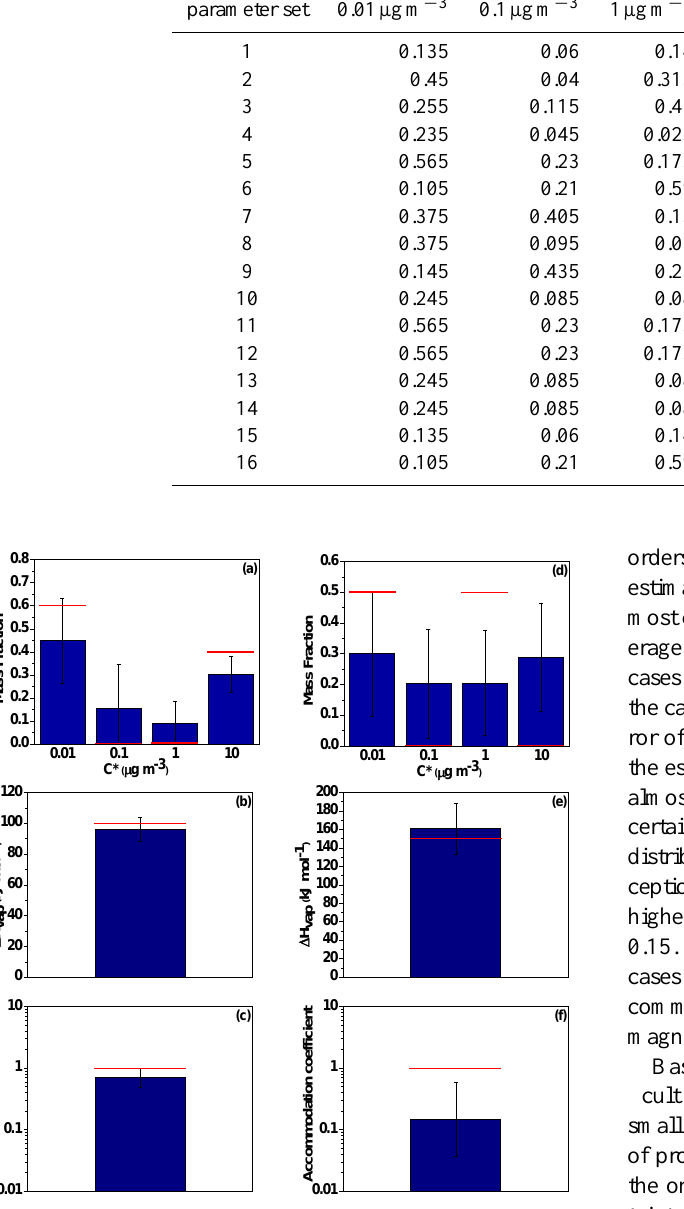
Figure 5. Estimated (bars) and true property values (red lines) using 12 TD measurements, for two types of OA. (a) volatility distribution, (b) ΔΗ vap , (c) a m for OA with 60% 0.01 μg m -3 and 40% 10 μg m -3 , ΔH vap =100 kJ mol -1 and a m =1 and ( d ) volatility distribution, ( e ) ΔΗ vap , ( f ) a m for OA with 50% 0.01 μg m -3 and 50% 1 μg m -3 , ΔH vap =150 kJ mol -1 and a m =1 for: The error bars represent the uncertainty of the estimated value .